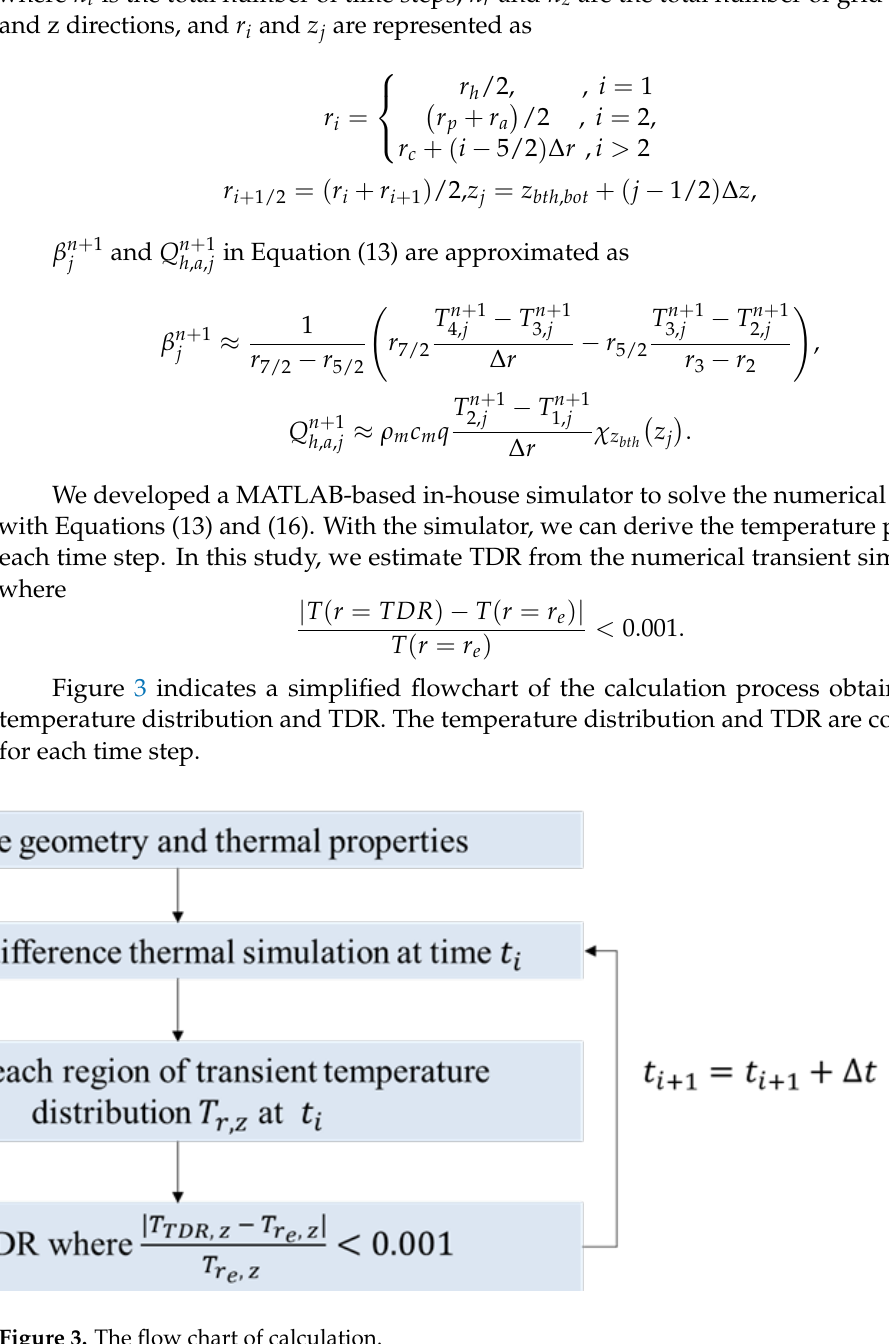
Table 1. Parameters of drilling operation and formation. Parameter